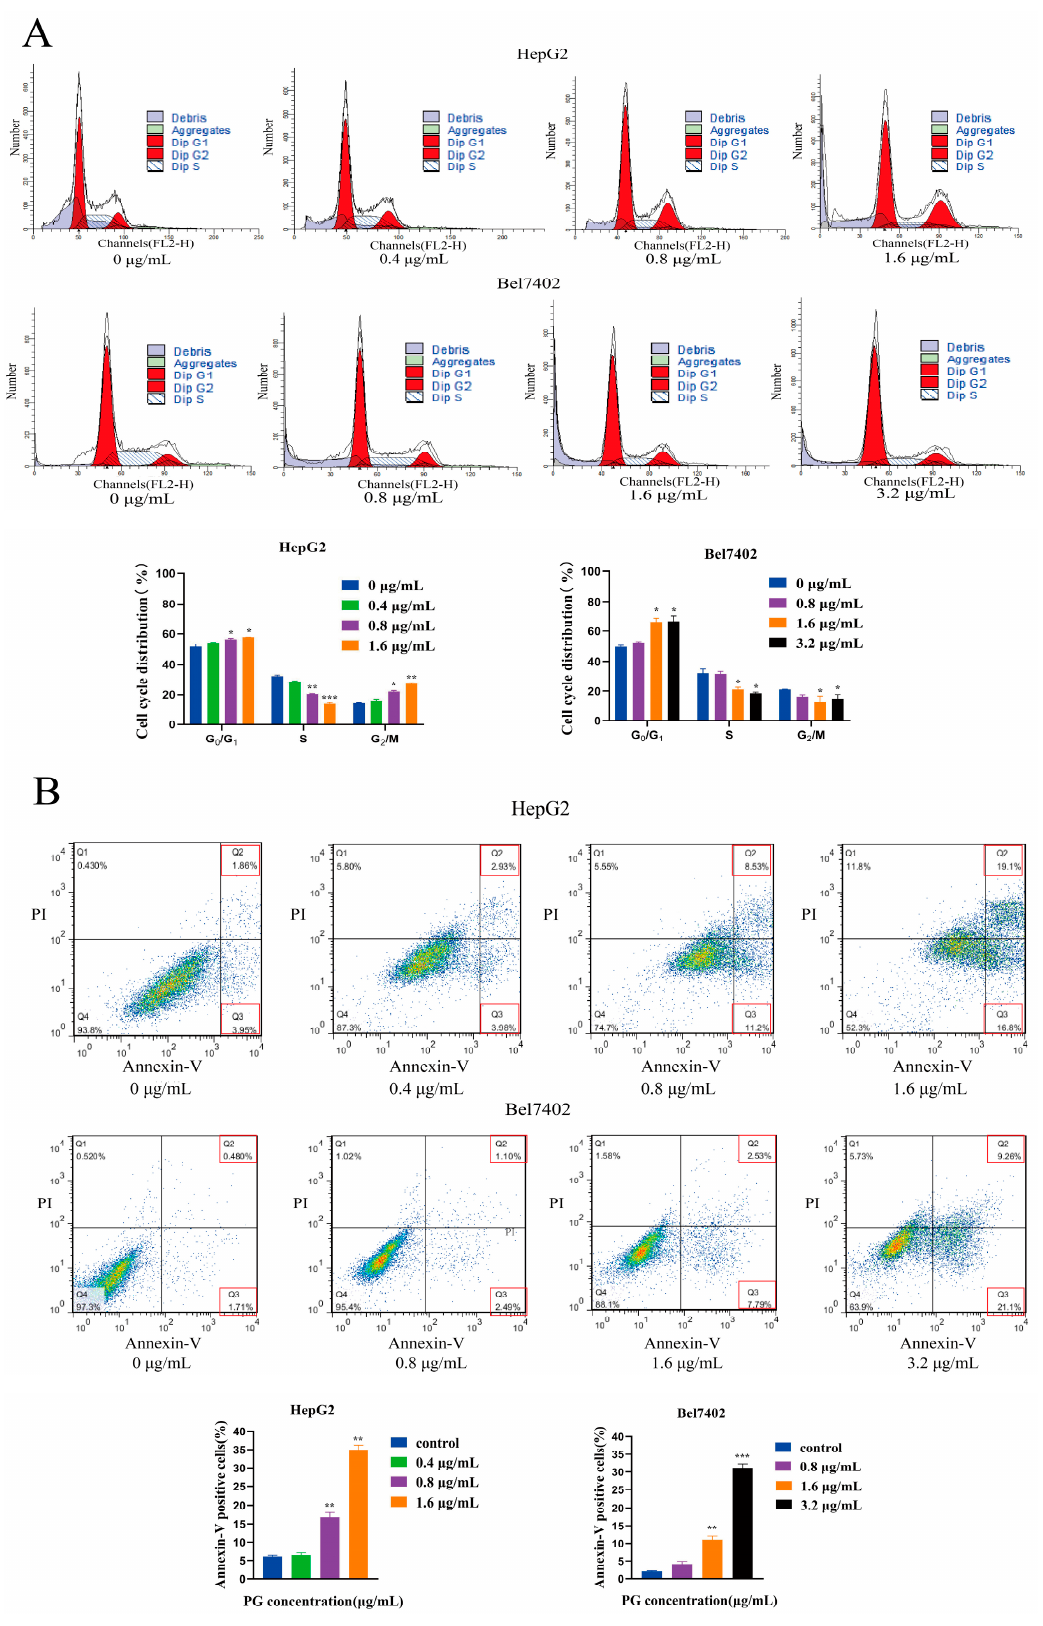
Figure 2. ( A ). Effect of PG on HepG2 and BEL7402 cell cycle. ( B ). Effect of PG on apoptosis of HePG2 and BEL7402 cells. The combined percentage of cells in Q2 and Q3